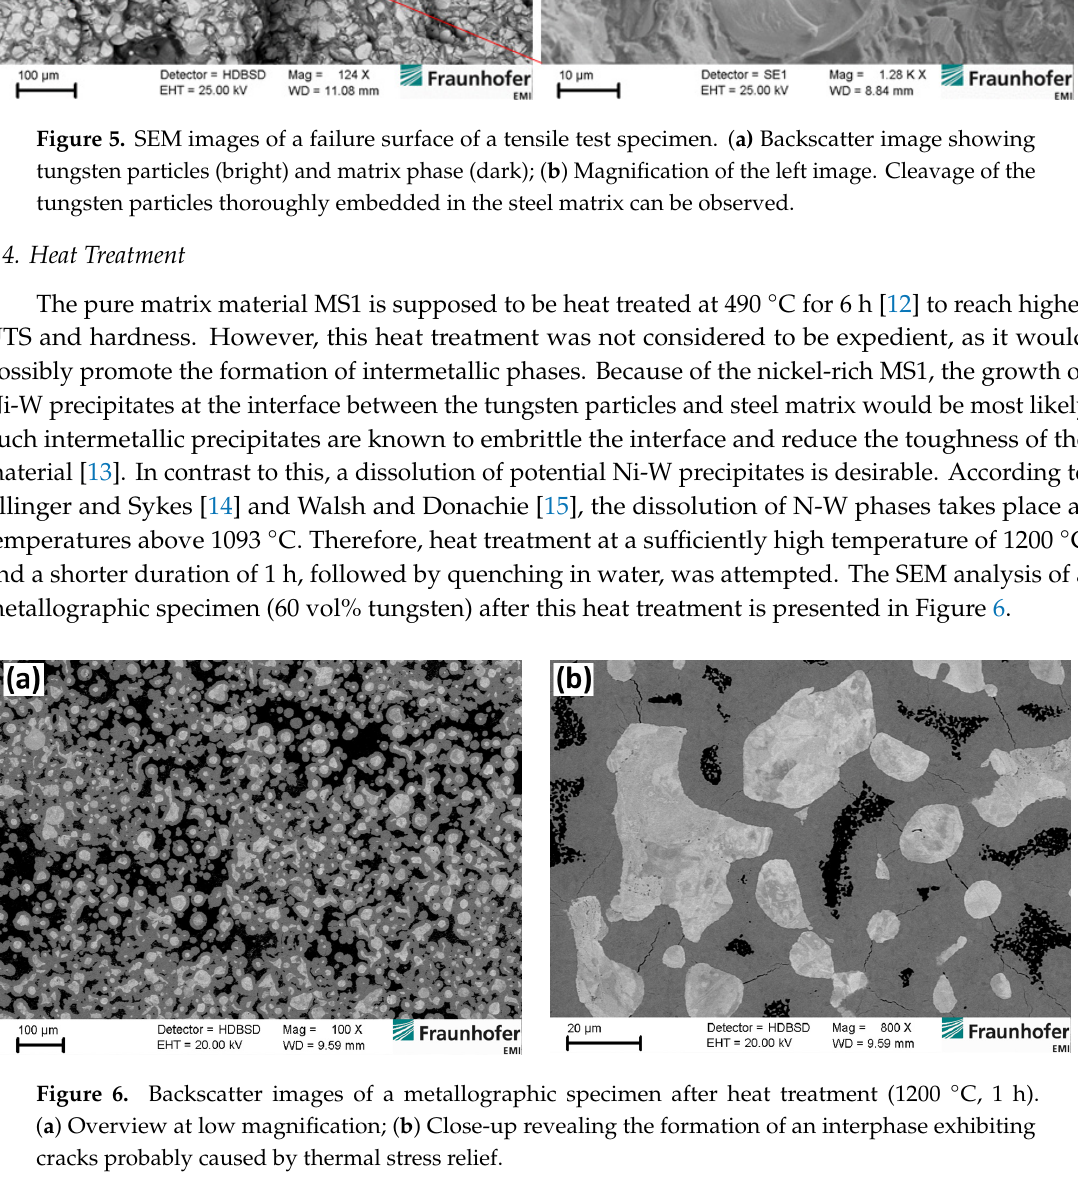
Figure 7. EDS measurement of the interphase. The spectrum contains all measurable elements of the MS1 matrix and tungsten. Additionally, a fracture surface of a heat-treated sample was analyzed in the SEM. From Figure 8a, it can be concluded that the interface between tungsten particles and steel matrix was weakened due to heat treatment. A ripping-off of the particles at the fracture surface can be stated. Moreover, a radial pattern around the particles can be observed, indicating diffusion processes taking place during the heat treatment. In the backscatter image (b), a cracked tungsten particle can be seen. A core-shell-like structure was formed because of the diffusion processes started by the heat treatment.